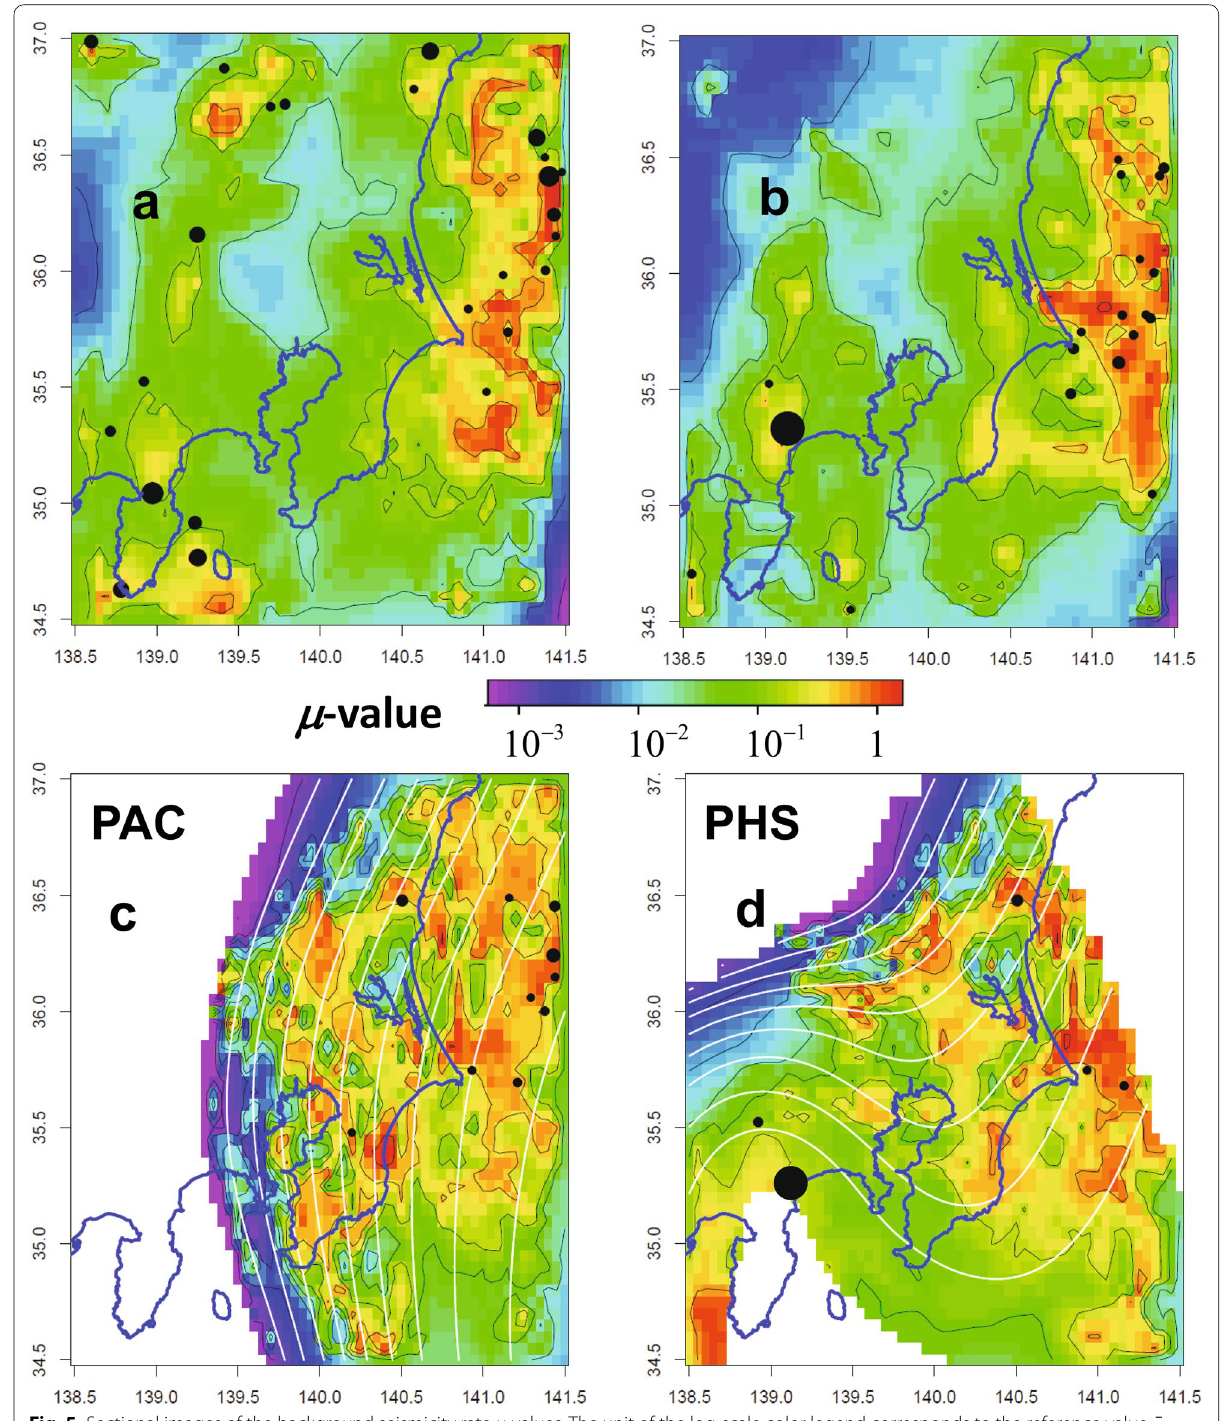
Fig. 5 Sectional images of the background seismicity rate μ -values. The unit of the log-scale color legend corresponds to the reference value ¯ µ in Table 1 (Reference). The superimposed black disks corresponding to their sizes represent M6 and larger earthquakes, from the JMA Hypocenter Catalog, that occurred over the last 96 years. The depth ranges used in plotting the black disks are the same as those in the Fig. 4